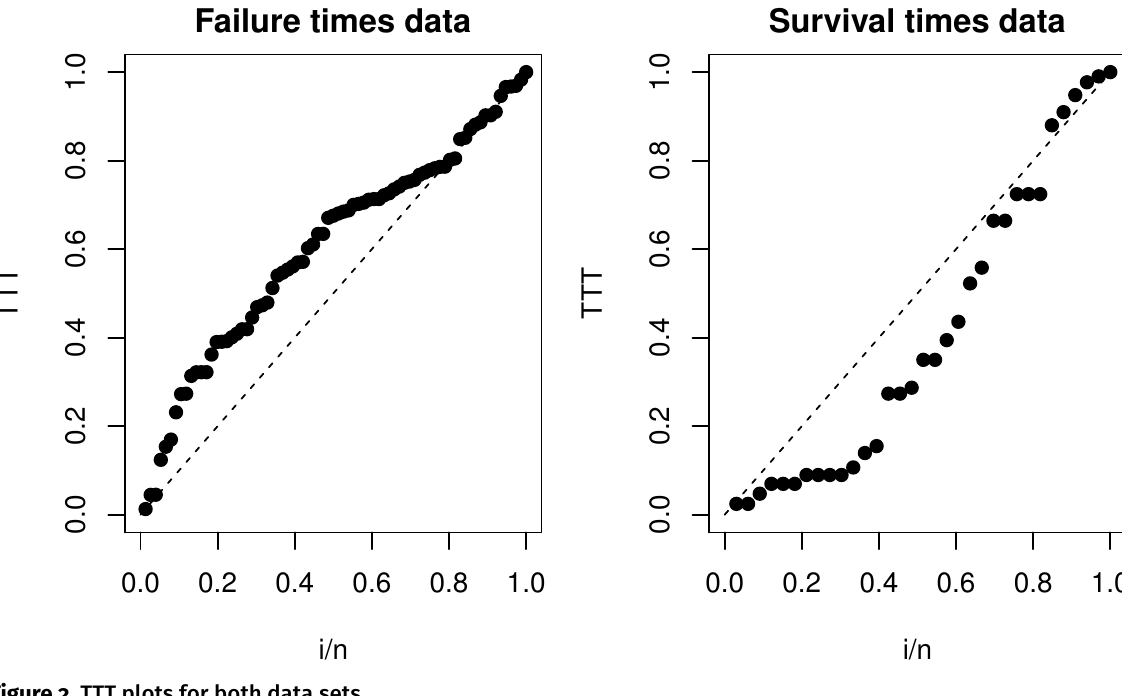
Figure 2. TTT plots for both data sets.